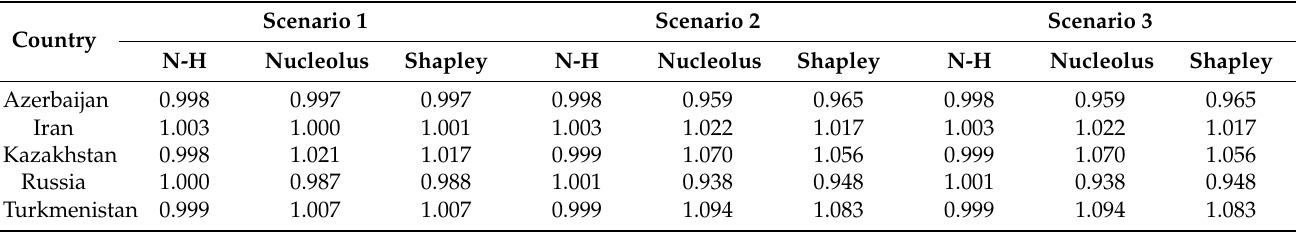
Table 7. The propensity to disrupt for the game theoretic solutions under different